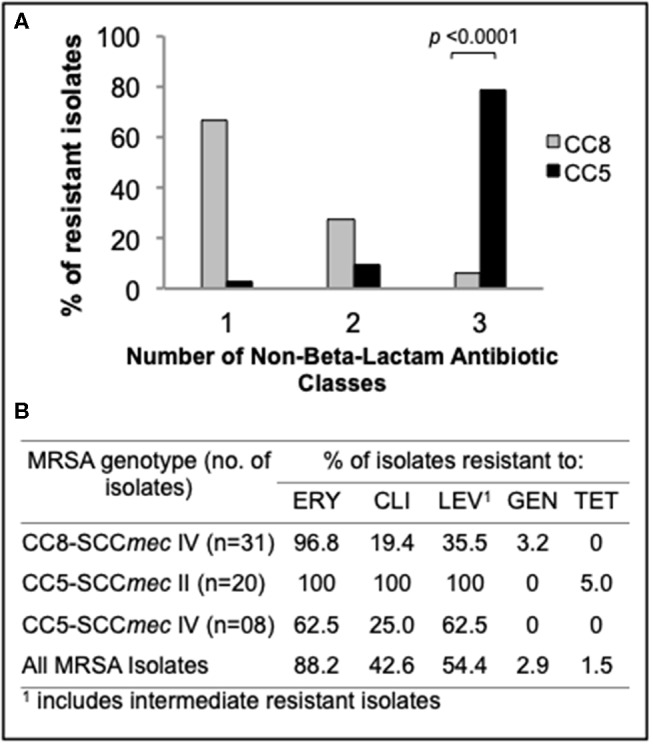
Antimicrobial susceptibility profile of the main ocular MRSA clonal complexes. (A) Frequency (%) of CC5 and CC8 strains resistant to additional non-beta-lactam antibiotic classes. (B) Resistance rates for common antibiotics representing 5 different classes. Statistical significance was determined using Fisher's exact test.